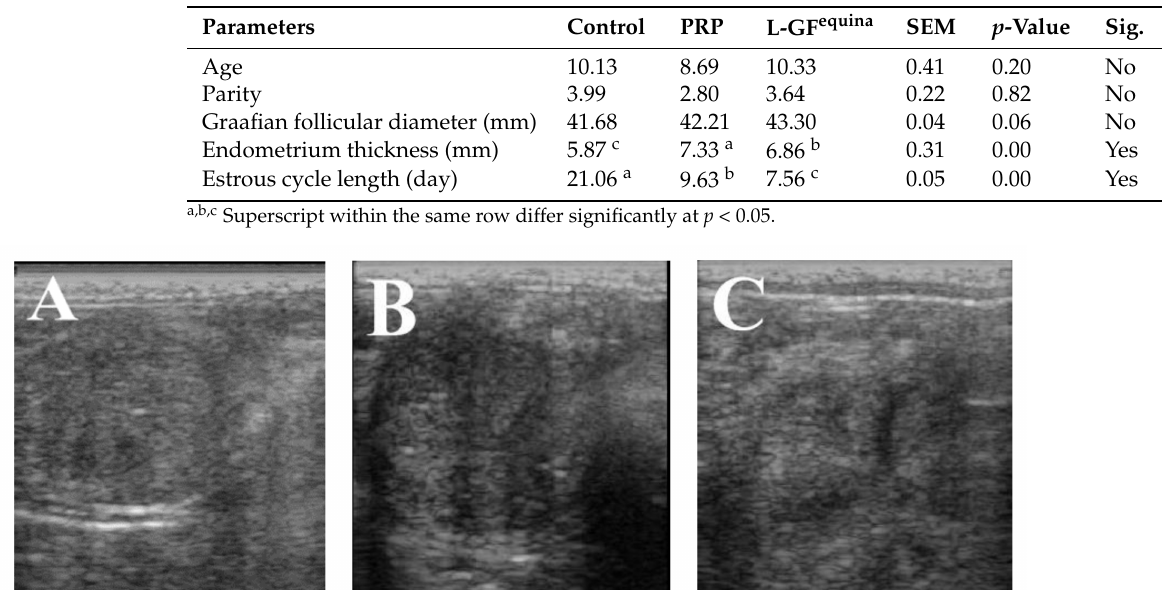
Table 1. Effect of platelet-rich plasma (PRP) treatment on the mature Graafian follicular diameter, endometrial thickness, and estrus cycle length of Arabian mares.